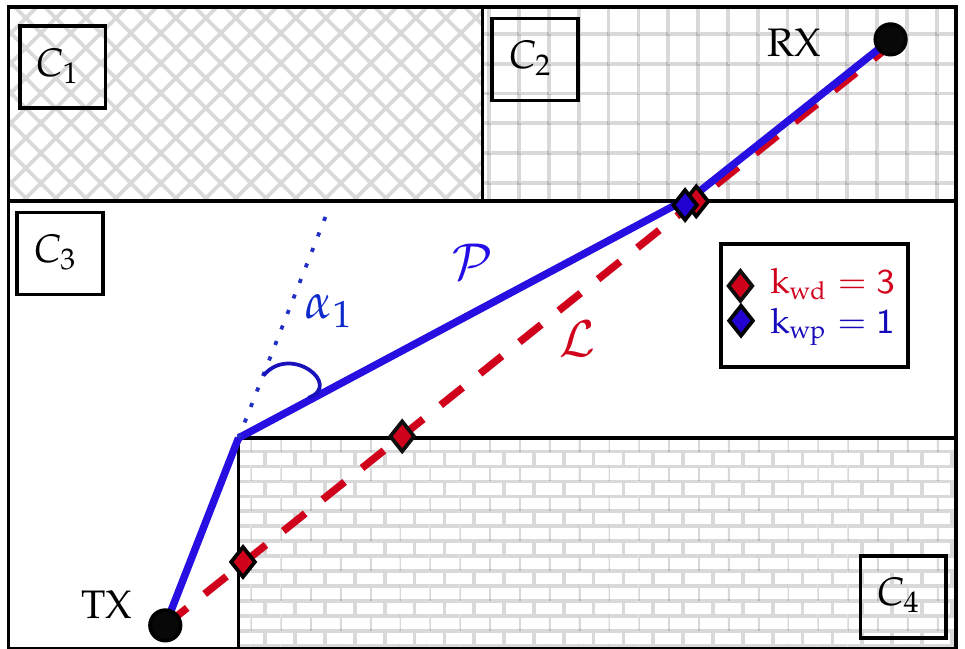
from TX to RX. Along it, the blue and red Figure 1. The blue line is the concatenated geodesic path P diamonds represent the points at which walls are crossed along the geodesic path and direct path respectively. The number of walls crossings are enumerated by k wd and k wp . The direction changes along the path are indicated by α i , i 0, . . . , corner count . The distinct path-connected spaces P ∈ { } are indicated by C j , j 1, . . . , J ∈ { }